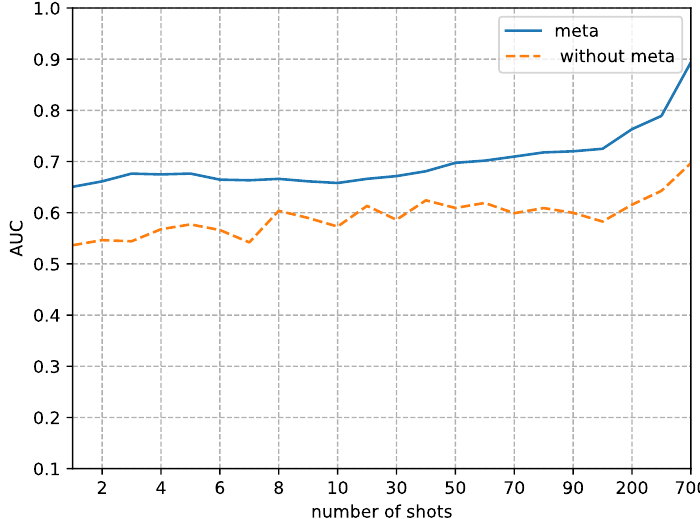
Figure 11. Comparison of AUC between random initial weights (without the proposed method) and meta-learning of detecting images altered by NeuralTextures manipulation methods. The x-axis is the size of the fine-tuned training set and the y-axis is the value of